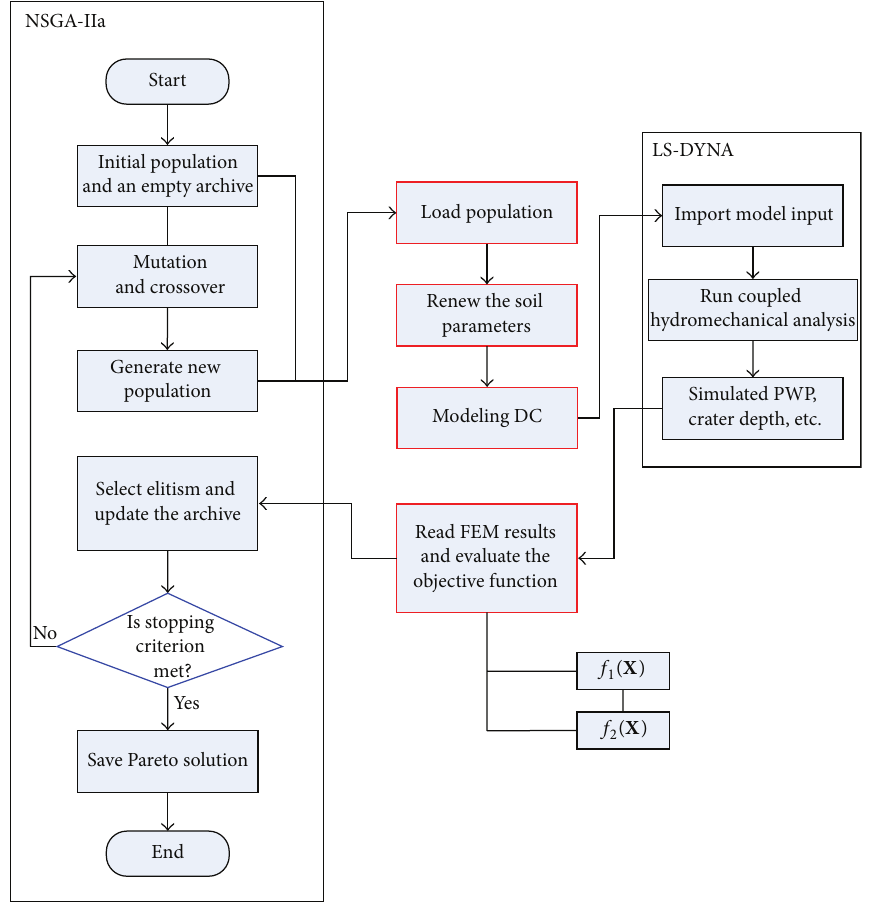
Figure 5: Flow chart of multiobjective back analysis.